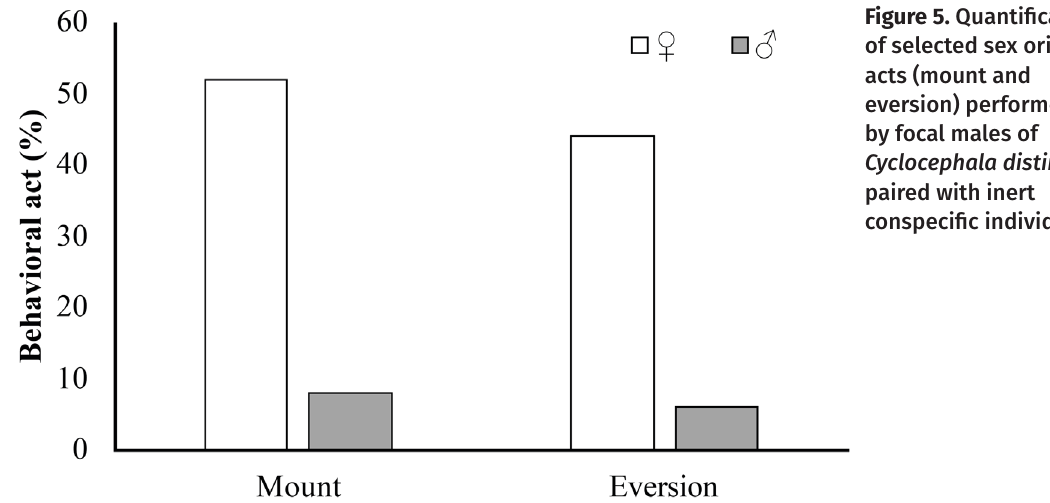
of selected sex oriented acts (mount and eversion) performed by focal males of Cyclocephala distincta paired with inert conspecific